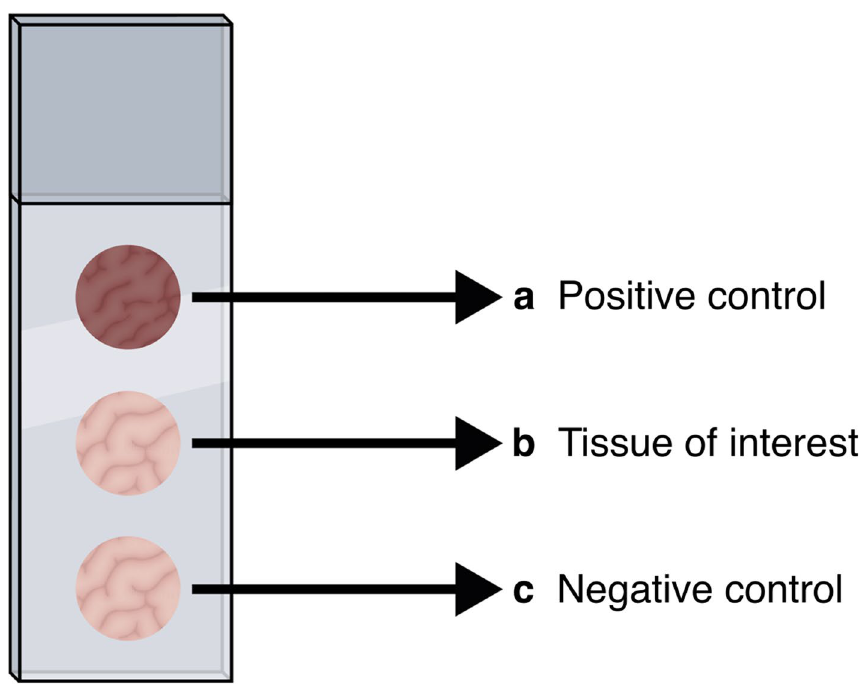
Figure 1. Standardized structure scheme of the slides for the immunofluorescence staining. ( a ) Positive control—represented by samples of a random ovary or an endometrial cancer—was assessed to strengthen the technique to eliminate any mislabeling ( b ) samples of the interest tissues—peritoneal, deep infiltrating or ovary endometriosis and the eutopic or non-endometriosis endometrium ( c ) an additional sample of the interest tissue itself represented the negative control to mitigate any labeling mistake of the